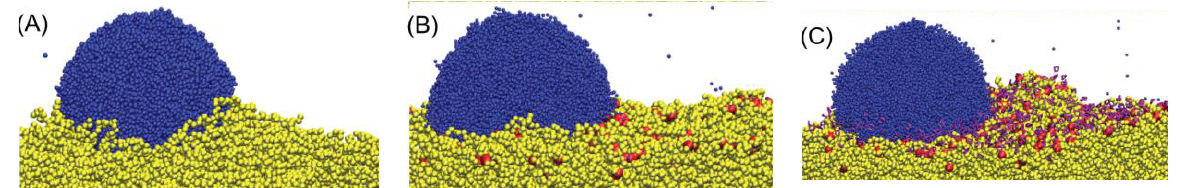
Figure 5. Graphical representation of the PDM changes during and after exposure to corona charges: ( A ) the surface of unaged PDMS is hydrophobic; ( B ) the presence of the oxidized methyl groups (~COO 2212 ) and Na + counter ions on the surface of aged PDMS make the surface hydrophilic, and ( C ) the diffusion of the small (D4) molecules to the oxidized surface leads to an increase in the contact angle and recovery of the surface hydrophobicity [29]. Reprinted with permission from Ref. [29]. Copyright 2012 American Chemical Society.